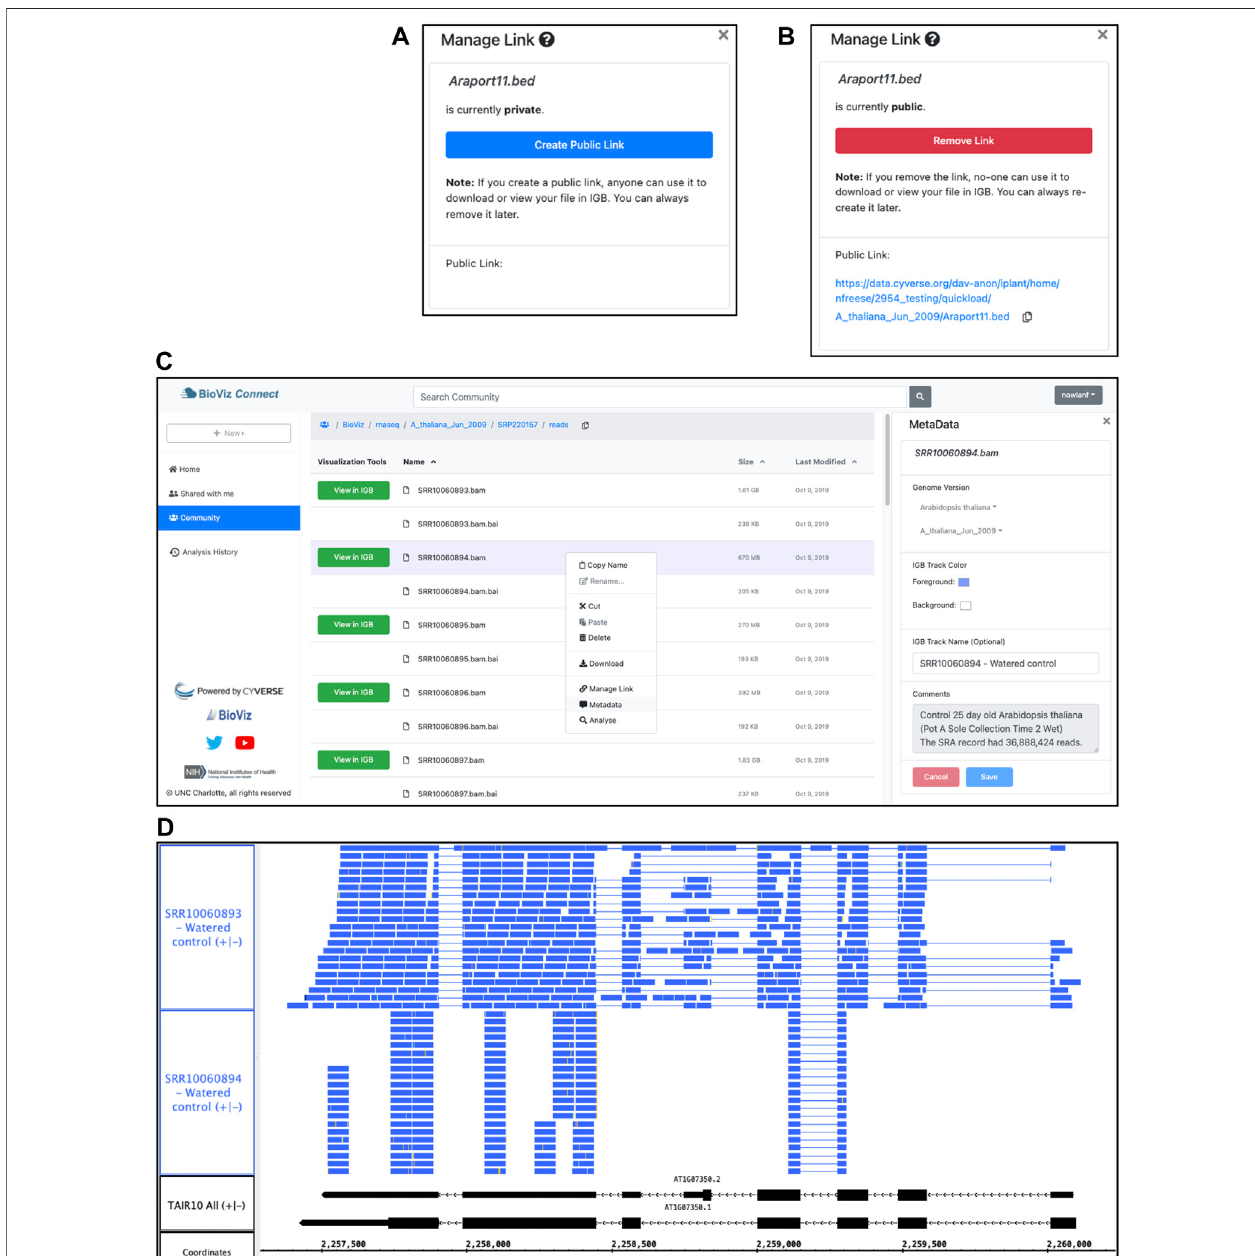
FIGURE2| BioViz Connect interfaceand IGBdatavisualization. (A,B) BioViz Connect “ ManageLink ” interface, fromtheright paneldisplay. Bydefault, fi lesarenot publiclyaccessible, and the interface appearsasin (A) . Clicking the button labeled “ Create Public Link ” creates apublic link,switching thedisplaytothe image shown in (B) . (C) BioViz Connect mainpage.Theleftpanelshowsshortcutstohome,shared,communityfolders.Themiddlepanellists fi lesandfolders.Therightpanelshowsthe selected fi le ’ smetadata. (D) SRR10060893.bamand SRR10060894.bam fi lesviewedinIGBoverlappingtheSR45ageneof A.thaliana .Thetracklabeled